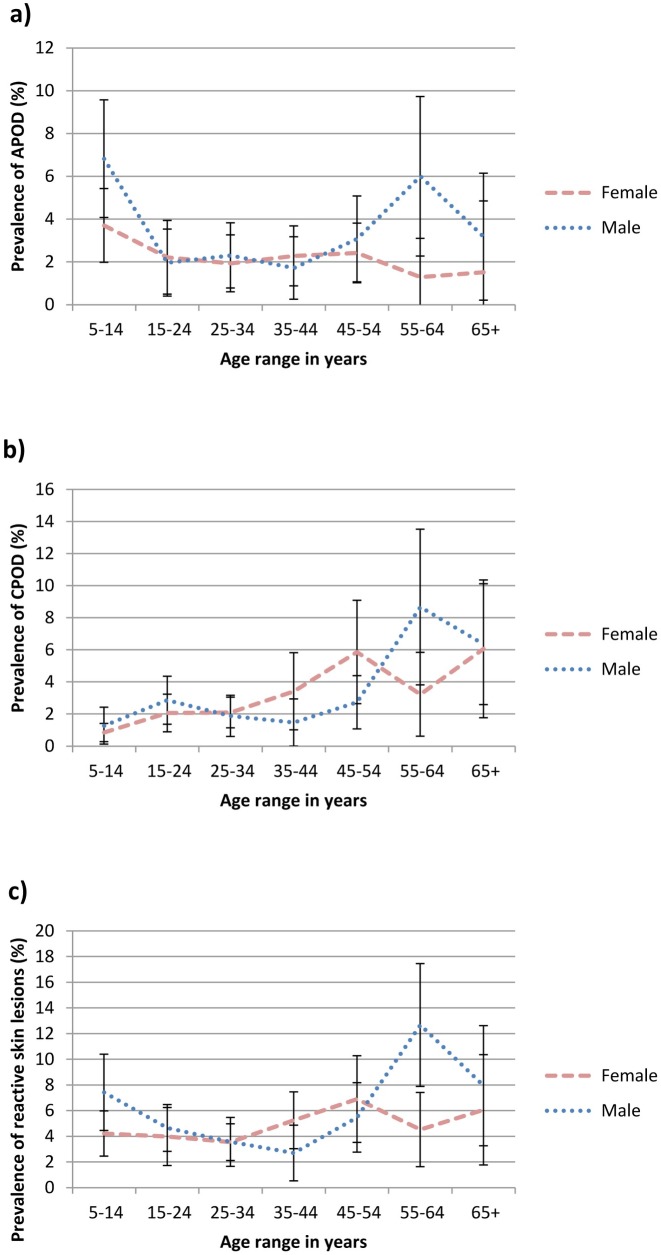
Age and gender-specific prevalence of a) acute papular onchodermatitis, b) chronic papular onchodermatiits and c) reactive skin lesions (i.e. acute papular onchodermatitis +/- chronic papular onchodermatitis +/- lichenified onchodermatitis) in endemic savanna communities, Kaduna State, Northern Nigeria. Error bars represent mean and 95% CI.